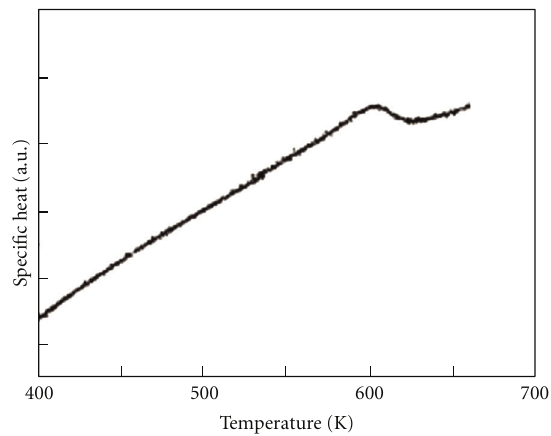
Figure 3: Temperature dependence of specific heat of SrBi 2 Ta 2 O 9 single crystal [8].